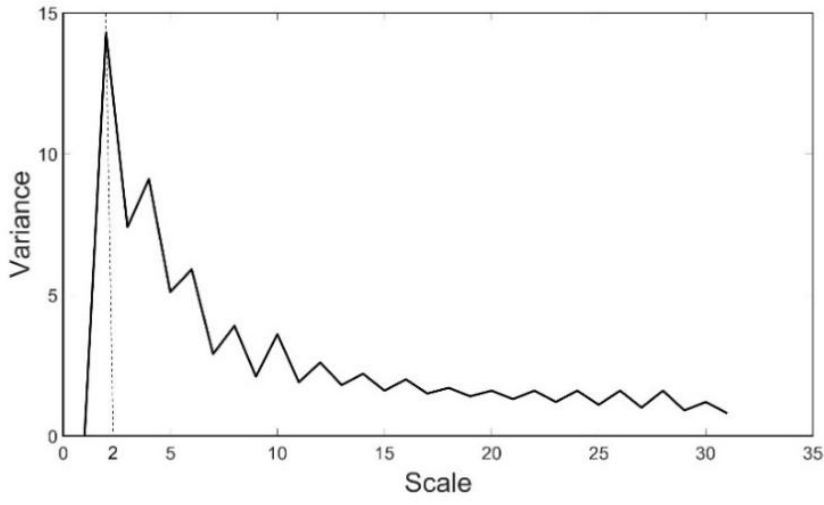
Figure 3. Wavelet transform coefficients versus the scales.